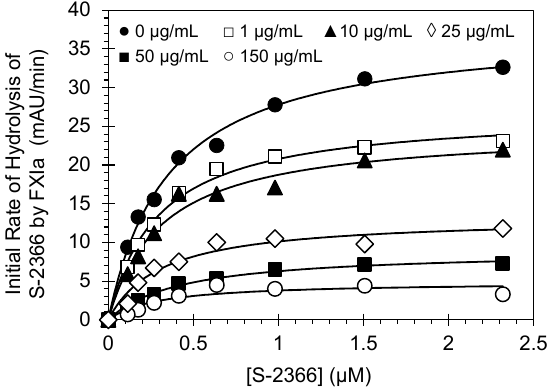
Figure 8. Michaelis–Menten kinetics of the S-2366 chromogenic tripeptide hydrolysis by human FXIa in the presence of different concentrations of LSAS. The initial rate of hydrolysis at different substrate concentrations was measured in pH 7.4 buffer using the wild type of full length FXIa. The concentra- tions of LSAS selected in this experiment were 0 ( ● ), 1 ( □ ), 10 ( ▲ ), 25 ( ◊ ), 50 ( ■ ), and 250 μ g/mL ( ○ ). Lines represent nonlinear regressional fits to the data by the Michaelis–Menten Equation (3). Table 4. Hydrolysis of the chromogenic substrate S-2366 by FXIa in the presence of LSAS a . [1] ( µ g/mL)